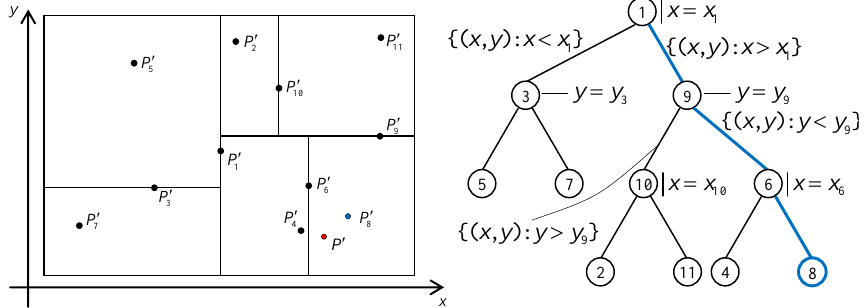
Figure 11. A graphic presentation of the procedure of finding the point being in the same area as point 𝑃 ′ .